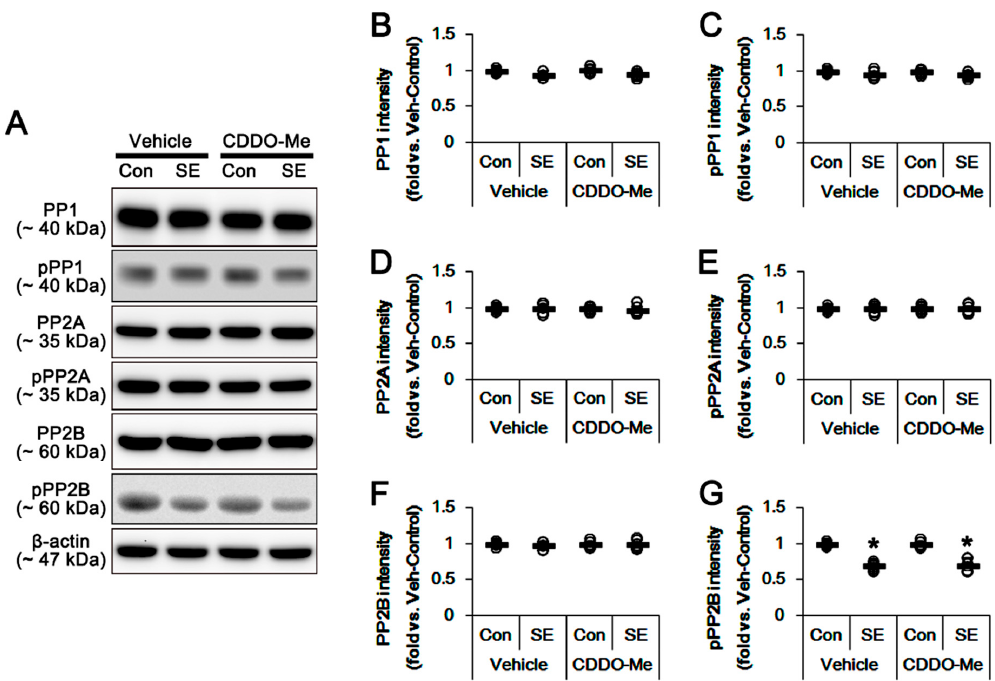
Figure 6. Effects of CDDO-Me on the expression and phosphorylation of protein phosphatase (PP) 1, PP2A and PP2B. CDDO-Me does not affect the expression and phosphorylation levels of protein phosphatase 1 ( PP1), PP2A and PP2B under physiological- and post-SE conditions. ( A ) Representative images for western blot of PP1, phospho (p)-PP1, PP2A, pPP2A, PP2B and pPP2B in the hippocampal tissues. ( B – G ) Quantifications of PP1, pPP1, PP2A, pPP2A, PP2B and pPP2B levels. Open circles indicate each individual value. Horizontal bars indicate mean value. Error bars indicate S.E.M. (* p < 0.05 vs. control animals; n = 7, respectively).